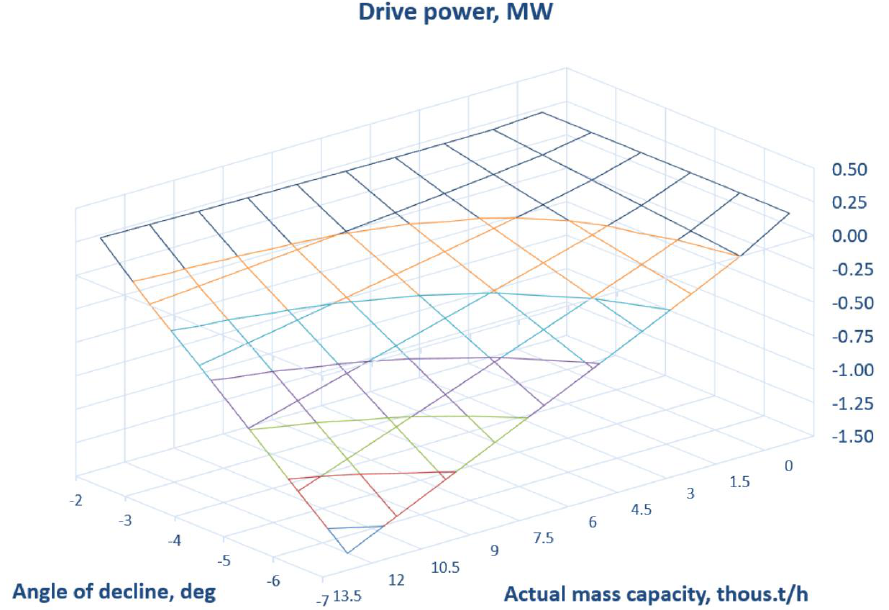
Figure 3. 3-D map of the power ranges of the main drive of the B1800 descending conveyor depending on the mass capacity and the angle of inclination downward (decline) of the conveyor route (calculations: QNK-TT).